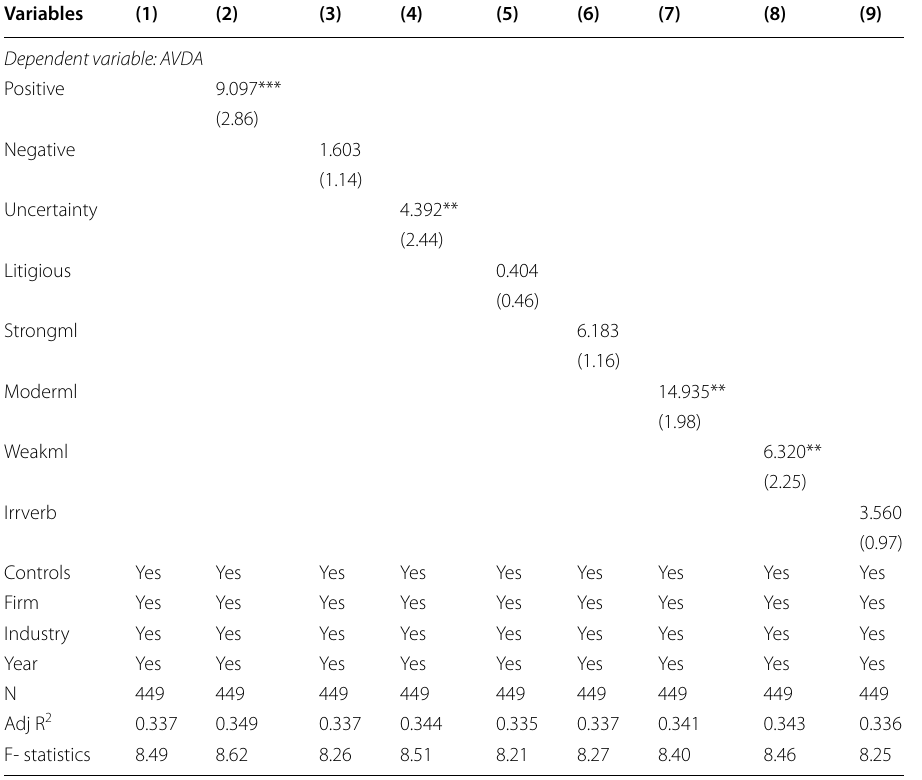
Table 5 Regressions using an alternative measure of earnings